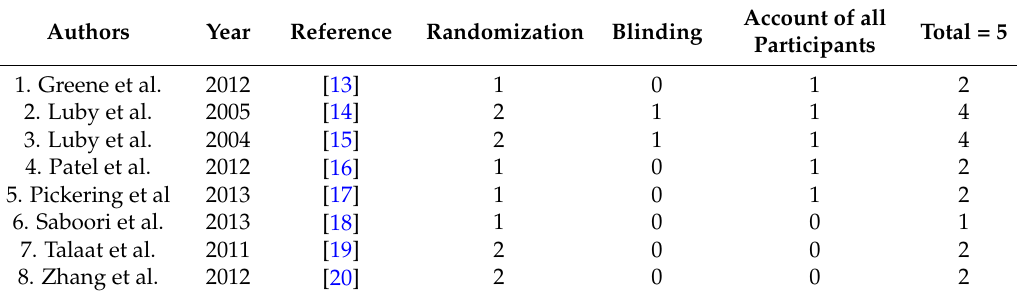
Table 3. JADAD scores for the included